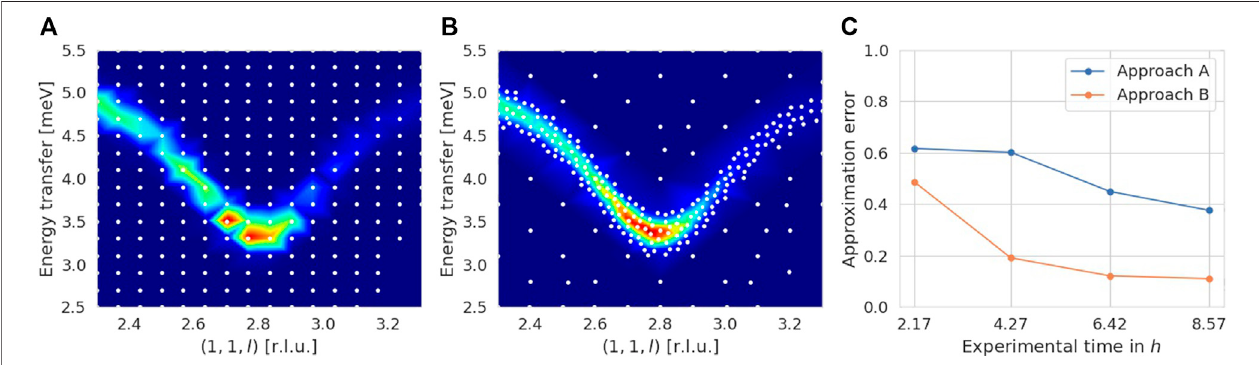
FIGURE1| Exampleforanoutcomeofourbenchmarkingprocedure.Twoapproaches[in (A) and (B) ]performanexperimentinthecontextofatestcaseincluding an intensity function of a phonon de fi ned on X (cid:1) [ 2 . 3 , 3 . 3 ] × [ 2 . 5 , 5 . 5 ] . In (C) , the benchmark result for this test case shows that approach (B) is able to reduce the approximation error from Section 4.3 quicker than approach (A) since it puts the majority of measurement points in the region of signal.